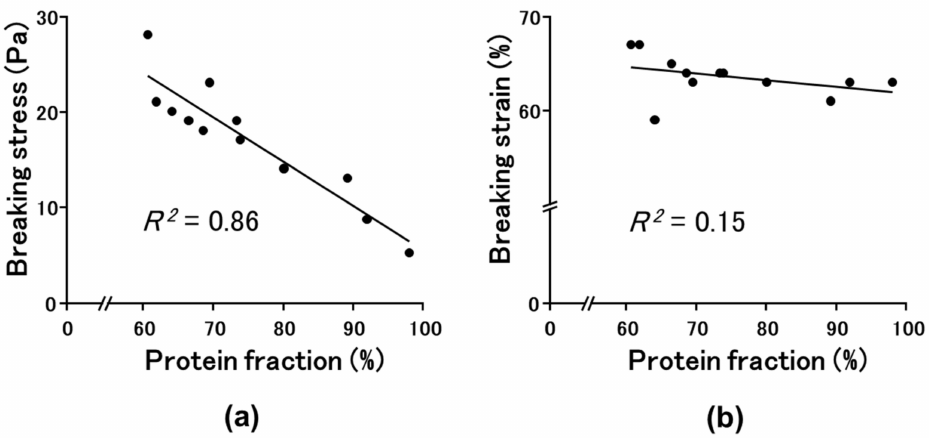
Figure 4. The relationship between breaking stress ( a ) or strain ( b ) and protein solubility in S3 (0.6 M NaCl and 8.0 M